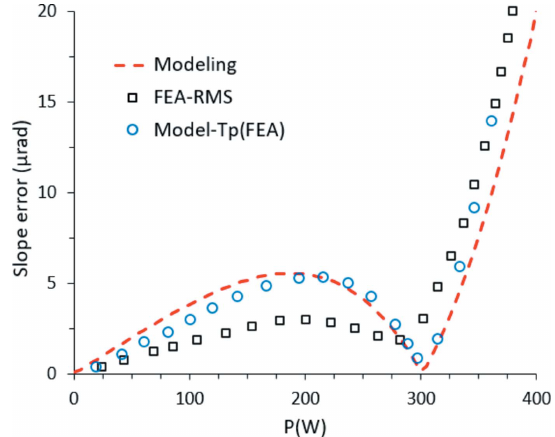
Figure 3 Slope error calculation from equations (6) and (7) (red dashes) compared with FEA results of Zhang et al. (2013). Blue circles are obtained from T p values extrapolated from FEA.